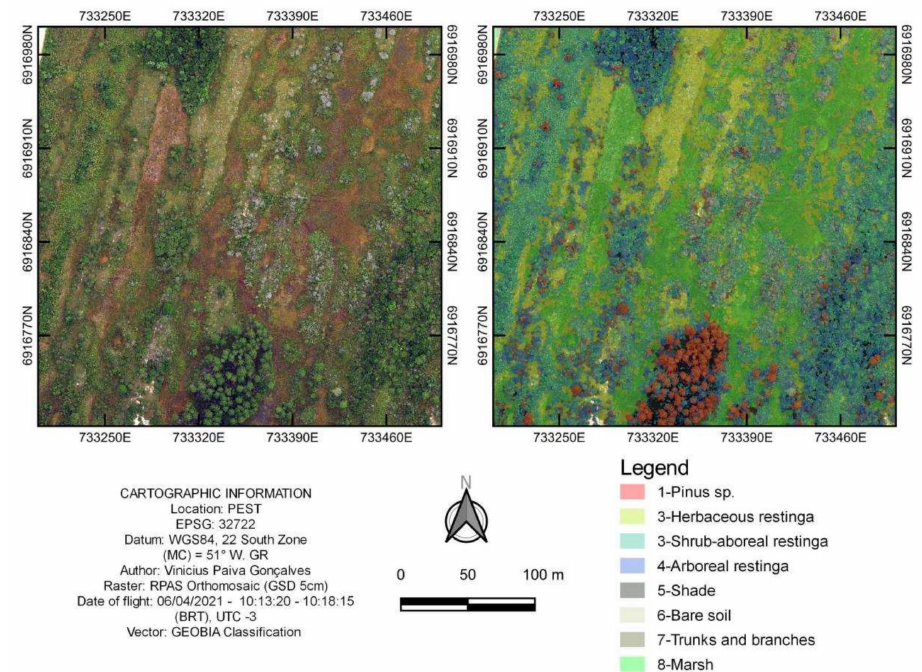
Figure 9. Comparison of the PEST area orthomosaic and classified images (higher kappa), overlaid with 65% transparency. CRS: EPSG 32722. Horizontal datum WGS84, UTM projection system, 22 South Zone. MC 51 ◦ W. GR. Raster: RPAS Orthomosaic (GSD 5cm). Flight date: 06/04/2021, 10:13:20–10:18:15 Brasilia Time (BRT), UTC-3.